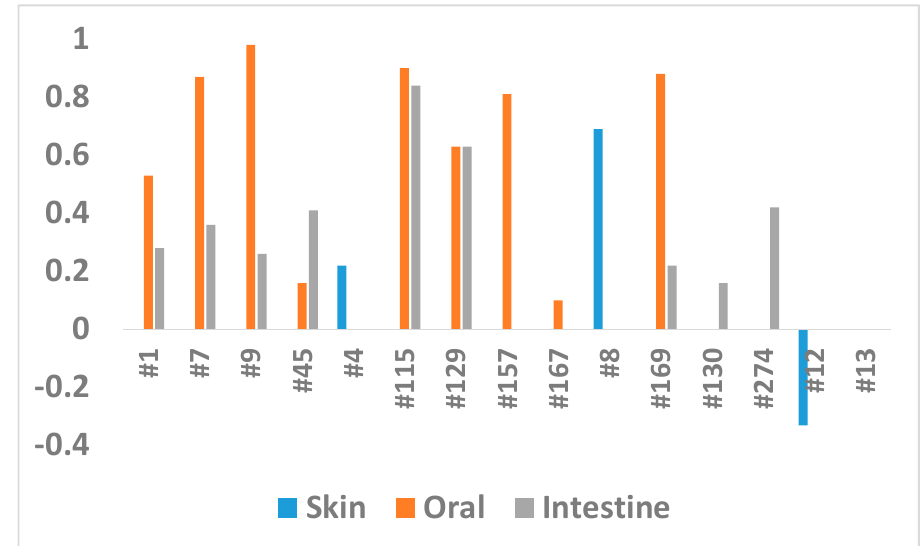
Figure 4. Comparison of the CDEI in three experiments. The Y axis shows the CDEI, while the X axis shows the extracts.